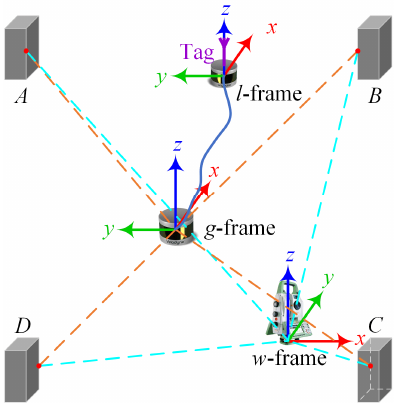
Figure 2. Coordinate systems.